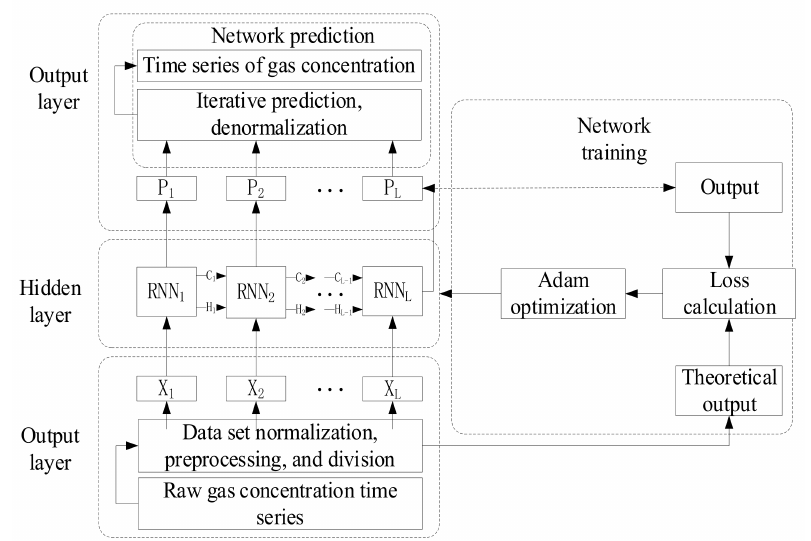
Figure 4. RNN gas concentration prediction process